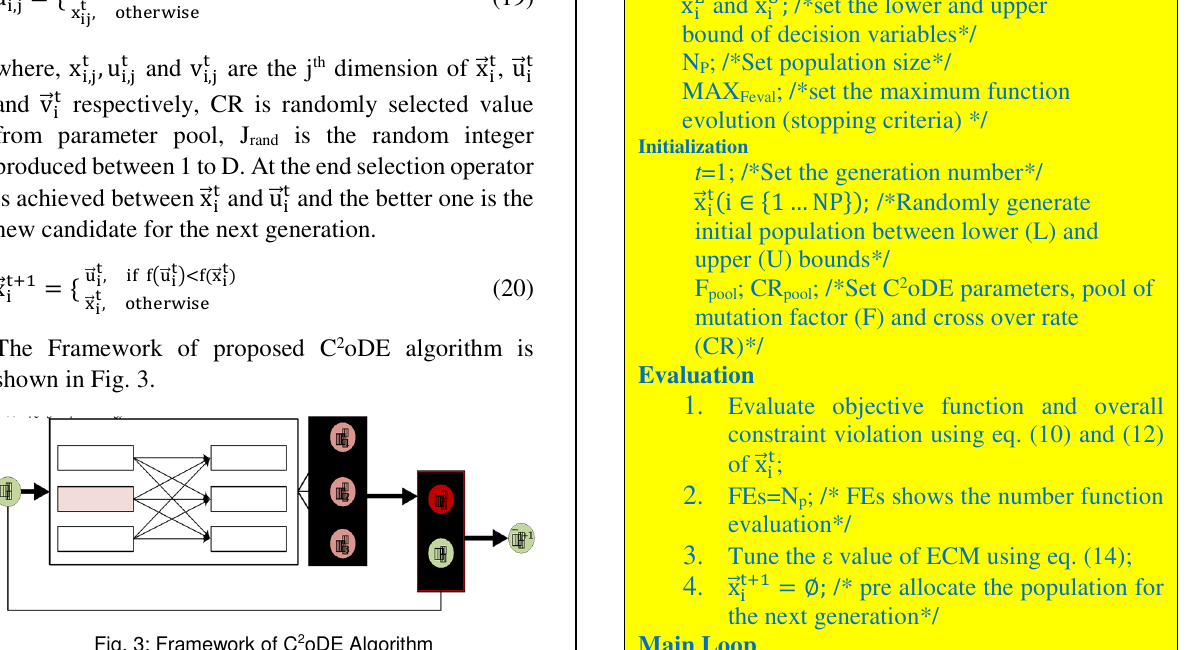
Fig. 3: Framework of C 2 oDE Algorithm